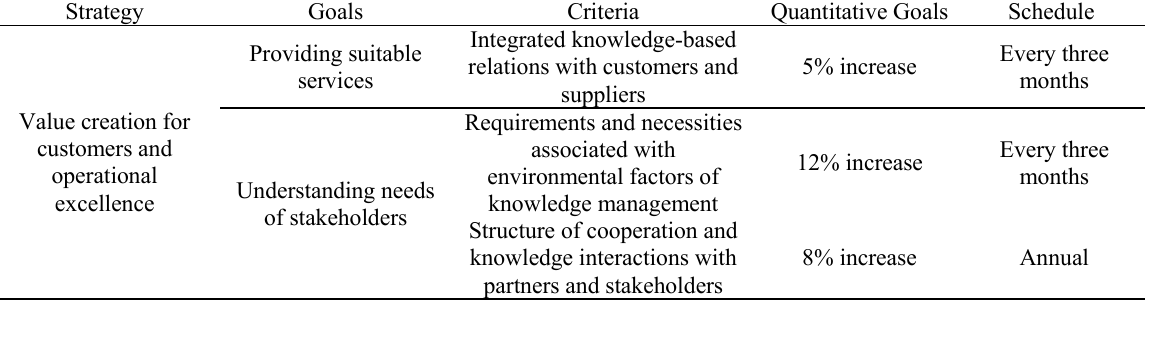
BSC for the stakeholders dimension in knowledge management evaluation in petrochemical industries